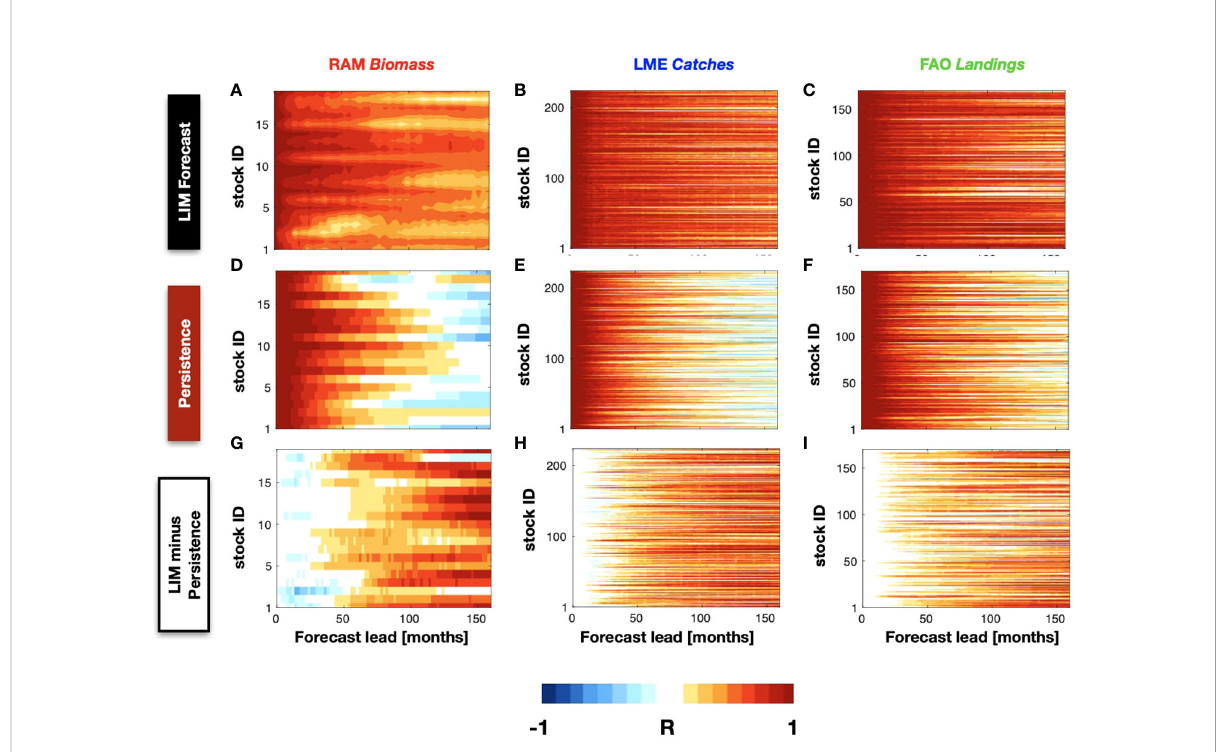
FIGURE 5 The LIM forecasting correlation skill as a function of different lead-times is displayed from the RAM (A) , LME (B) , and FAO (C) stocks. The persistence correlation skill for each of these stock is also shown for comparison in (D, E) , and (F) . A different between the skill of the LIM minus persistence is shown in (G , H) , and (I)